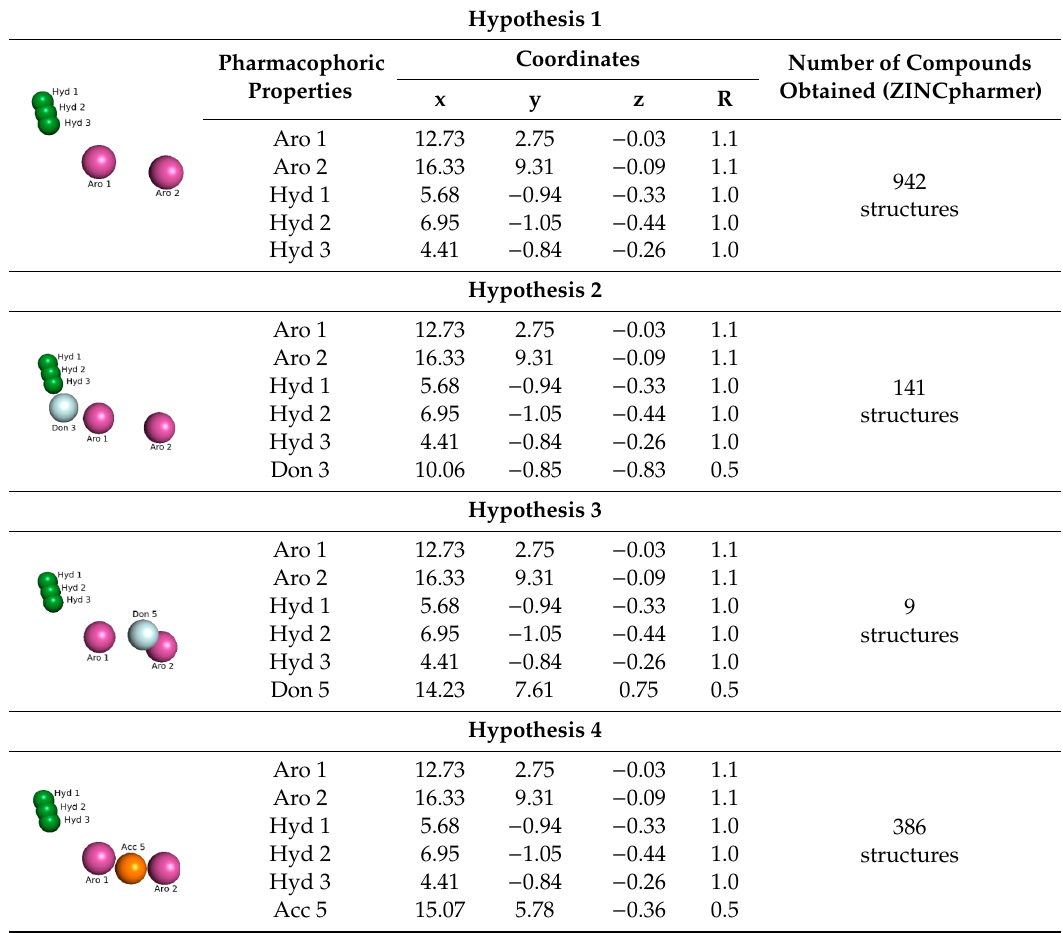
Table 4. Pharmacophore hypotheses via ZINCpharmer refinement.